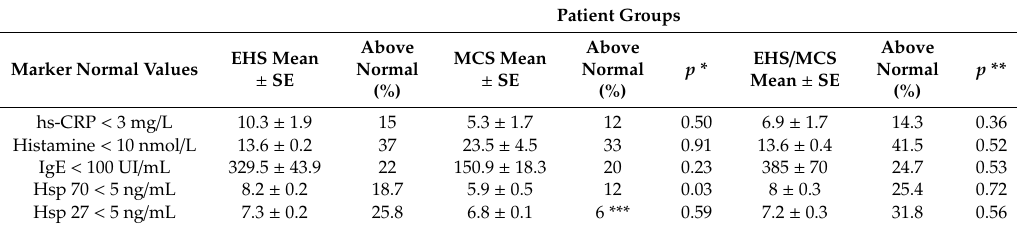
Table 4. Increase in low-grade inflammation-related biomarker mean blood level values in the peripheral blood of patients with EHS and / or MCS, according to References [9,10]. SE—standard error; hs-CRP—hypersensitive C reactive protein; IgE—immunoglobulin E; Hsp—heat-shock protein. Patient Groups Marker Normal Values